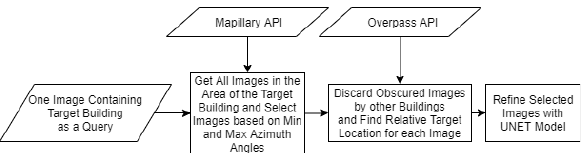
Figure 4. General workflow for the web